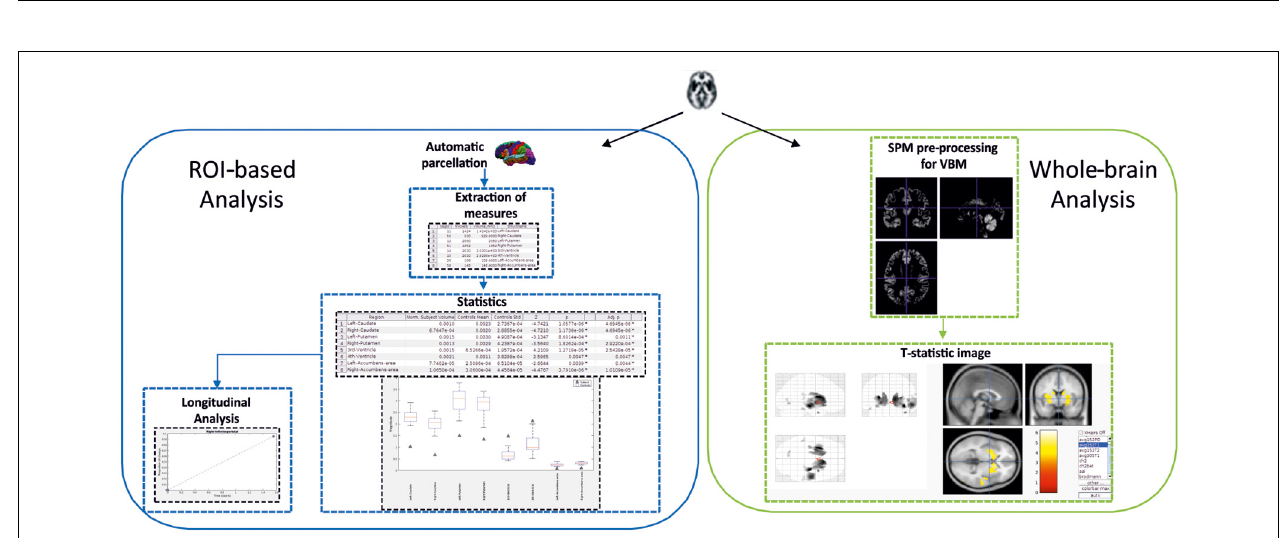
FIGURE 5 | Schema showing the two-fold strategy provided by SeSBAT. The ROI-based analysis (left) starts with the automatic parcellation of the brain, followed by the extraction of cortical and subcortical measures. Then, the results from the statistical comparison are reported in tables and graphs to identify potential prognostic factors. There is also an option for plotting results along time. The whole-brain analysis (right) consists of an exploratory voxel-based morphometry (VBM) approach that results in the visualization of a T-statistic image with an overlay of the affected voxels found in the single subject compared to the control group.